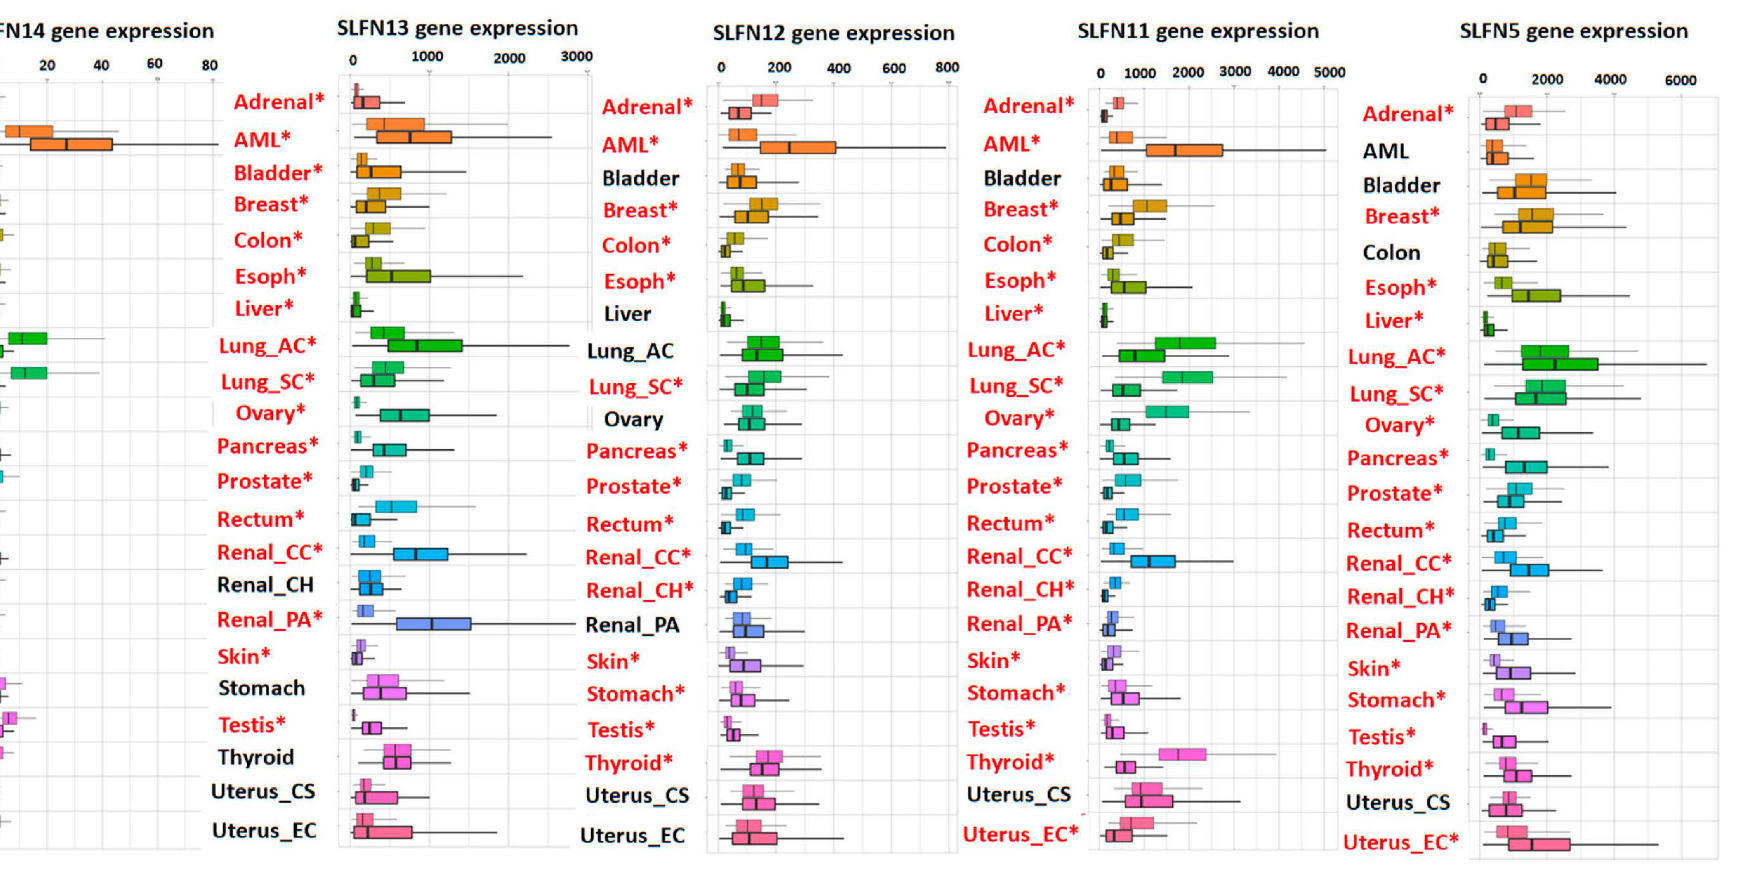
Figure 3. Analysis of TCGA datasets shows the expression levels of human SLFN5, SLFN11, SLFN12, SLFN13, and SLFN14 in various human tumors. Schlafens were abnormally expressed in pan cancers (right bars) by Tumor, Normal and Metastatic (TNM) plot compared to adjacent normal tissue (left bars). Significant differences by Mann–Whitney U test are labeled with red color and asterisk. Abbreviations: Lung_AC: lung adenocarcinoma; Lung_SC: lung squamous cell carcinoma; Renal_CC: renal clear cell carcinoma; Renal_CH: renal chromophobe cell carcinoma; Renal_PA: renal papillary cell carcinoma; Uterus_CS: uterine carcinosarcoma; Uterus_EC: uterine corpus endometrial carcinoma